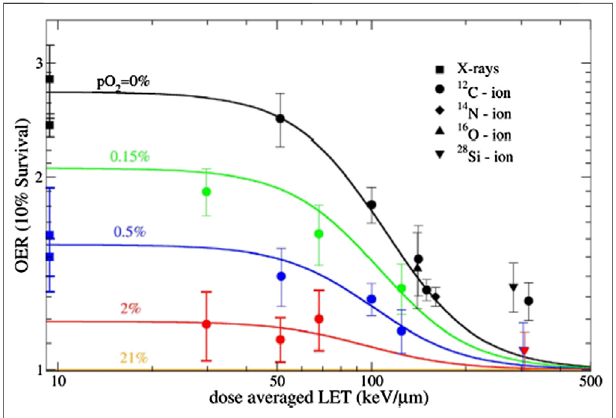
FIGURE8| DependenceofoxygeneffectiveratiofromLETinCHOcells. Plot from Ref. 44, reproduced under CC BY license from NPG publisher.